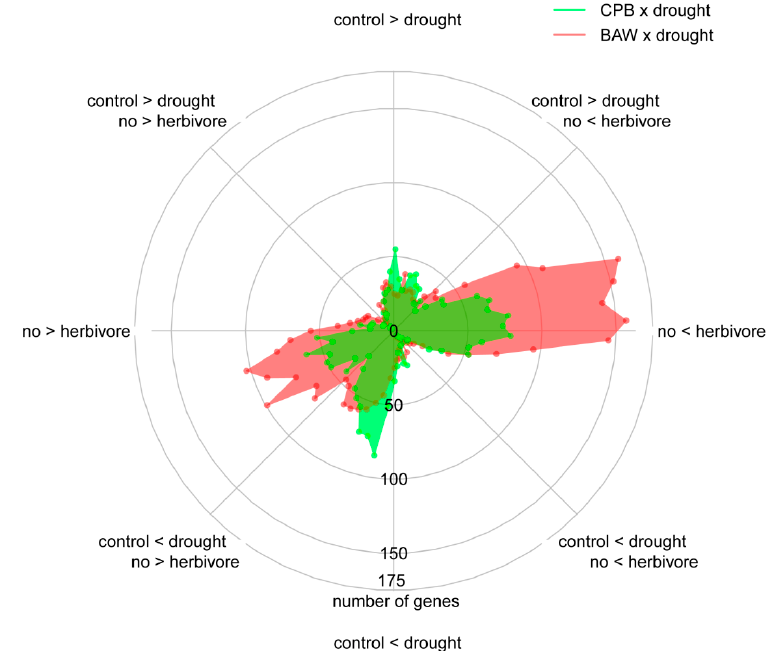
Figure 8. Effects of water availability and insect herbivory treatments on gradient directions of Solanum dulcamara transcriptional regulation. Data were generated from a 2 × 2 factorial design of watering treatments (well-watering (control) or drought] and herbivory (with or without) by Spodoptera exigua (BAW × drought; red) or Leptinotarsa decemlineata (CPB × drought; green), respectively. Each dot indicates the number of genes in one of the 72 categories of the circular histogram (based on gradient direction). Only genes with at least one significant expression change were included in the analysis.